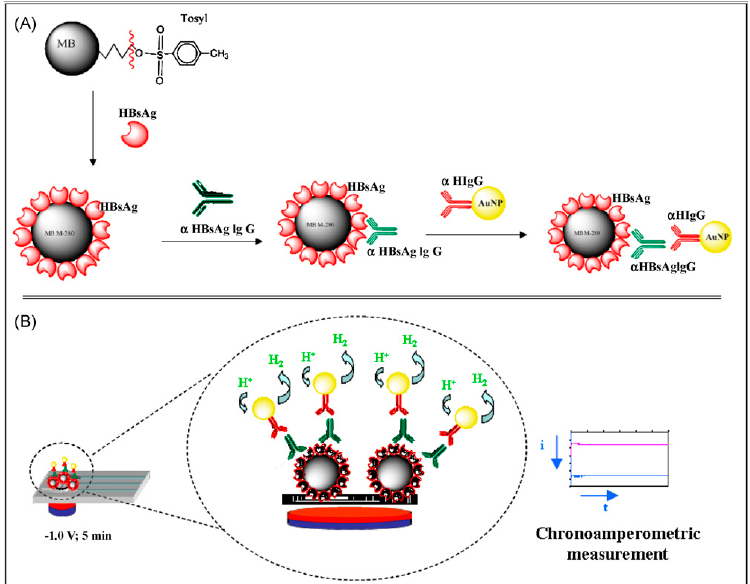
Figure 7. ( A ) Scheme of the experimental procedure performed. HBsAg are captured on the surface of magnetic beads, incubation with human serum that contains -HBsAg IgG antibodies and recognition with AuNPs conjugated with goat -human IgG antibodies. ( B ) The electrochemical detection procedure was based on the electrocatalytic hydrogen generation [6]. Copyright 2010. Reproduced with permission from Elsevier B. V.